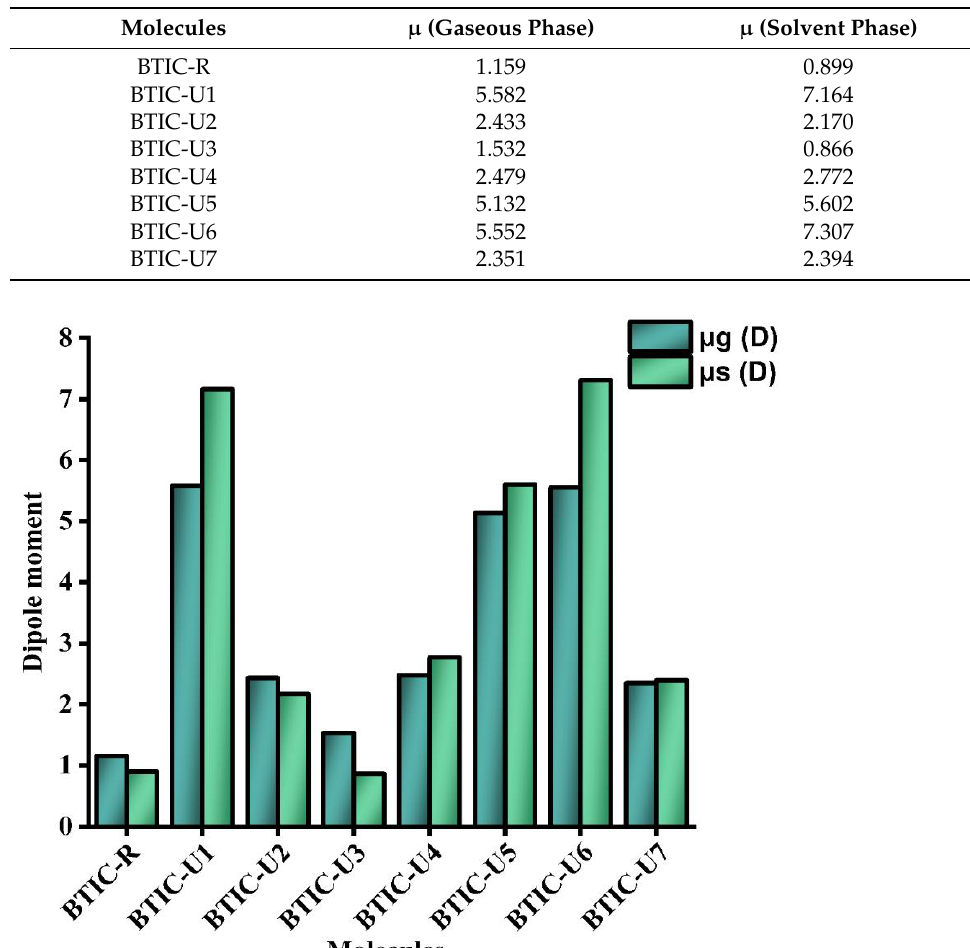
Table 5. Dipole moment ( µ ) of BTIC-R and BTIC-U1 to BTIC-U7 molecules.